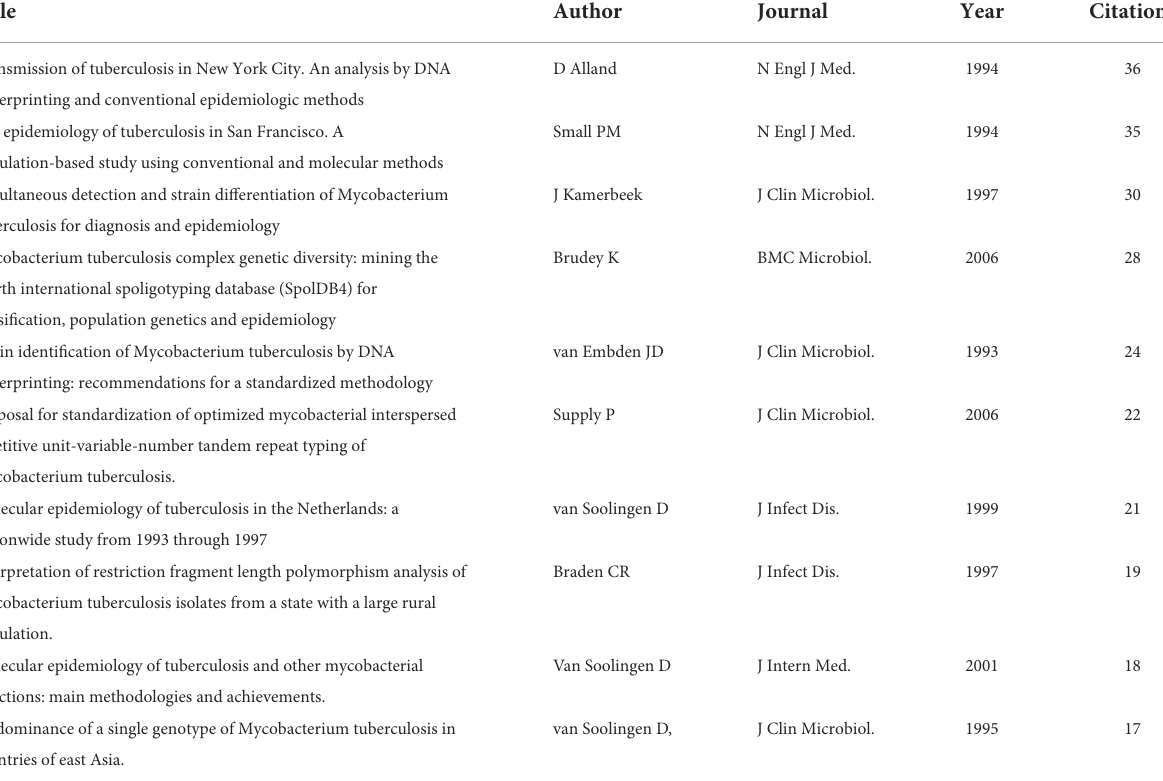
TABLE 4 Top 10 co-cited references of tuberculosis molecular